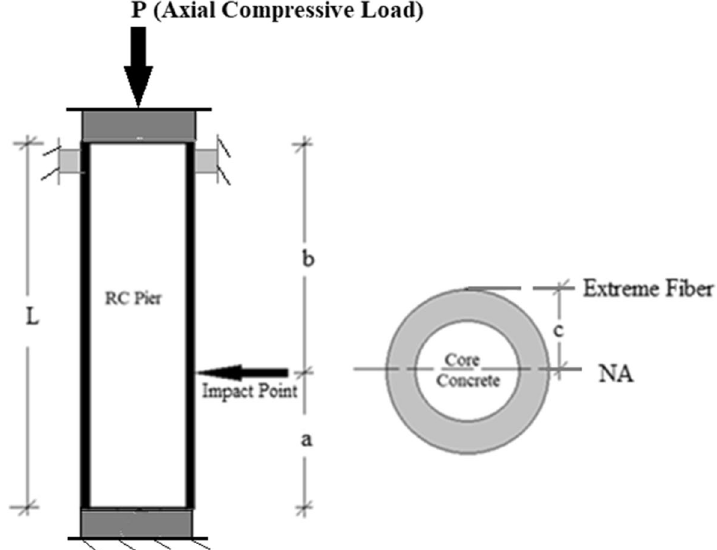
Fig. 3 Impact Location and Geometry of RC Bridge Pier (Roy et al.